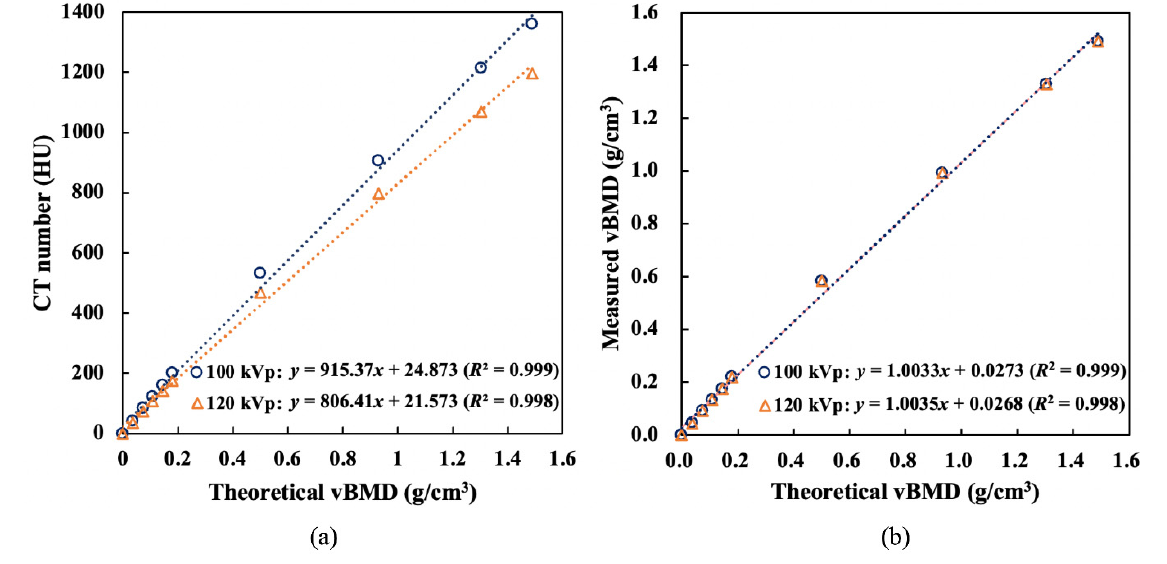
Figure 2. ( a ) Theoretical vBMD and CT number of the self-made bone phantom and ( b ) comparison between the theoretical vBMD and the measured vBMD obtained from TCM, scanned at 100 and 120 kVp.